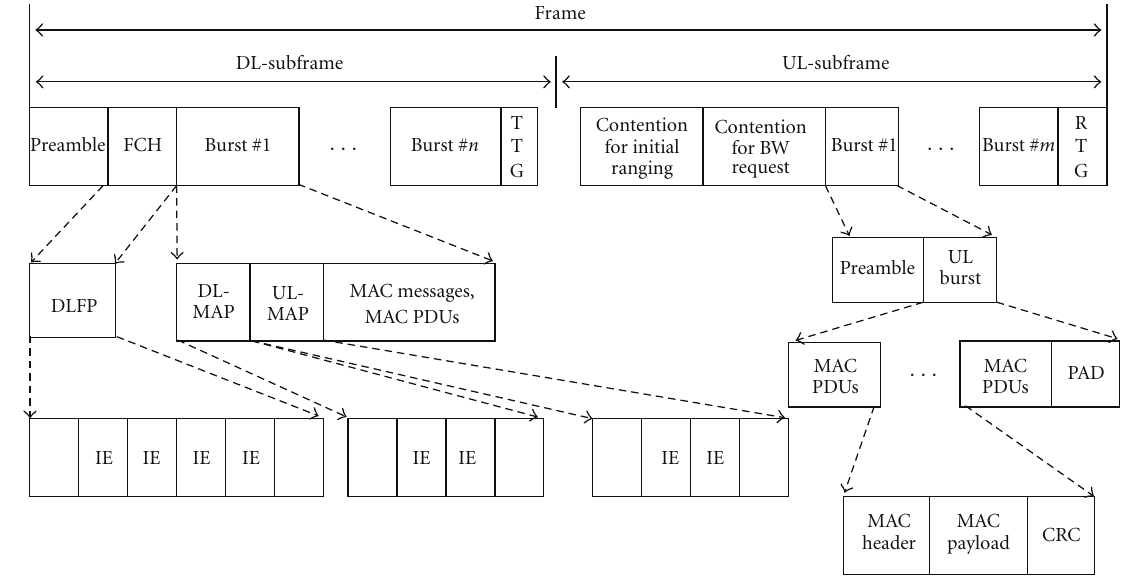
Figure 3: The frame structure of IEEE